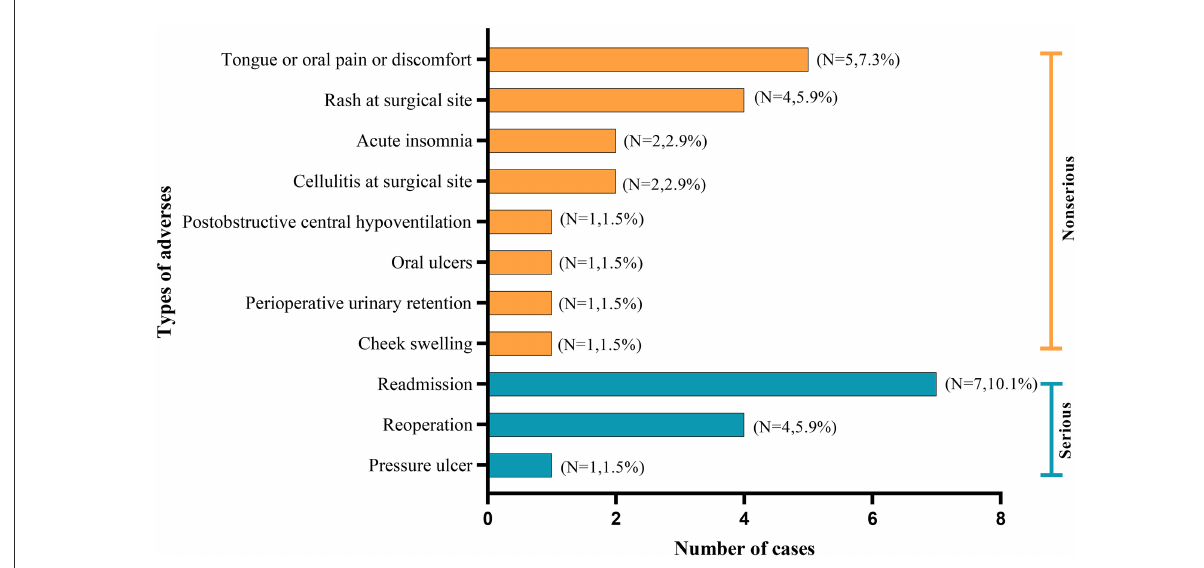
FIGURE4 The distribution of complications of studies included in the systematic